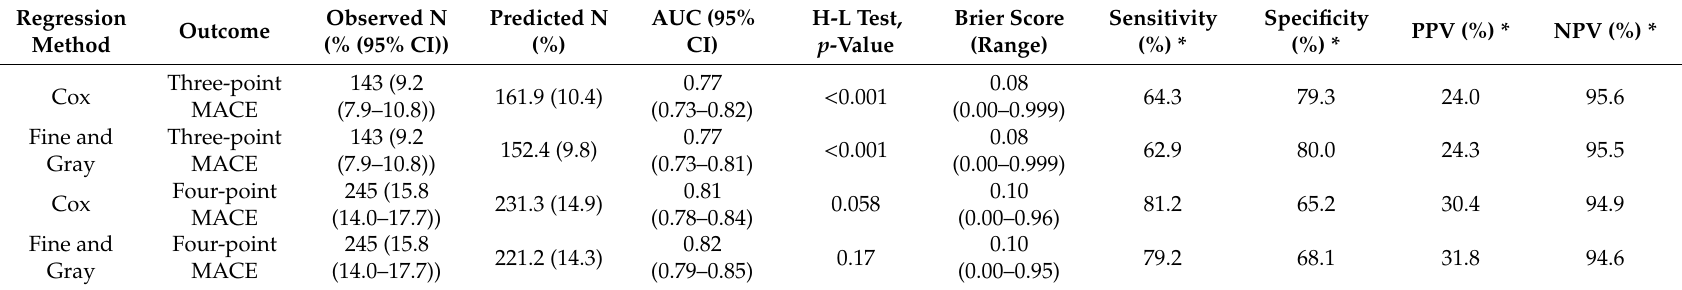
Table 3. Performance of five-year cardiovascular disease risk models for three-point major adverse cardiovascular events (MACE) and four-point MACE derived using a) Cox and b) Fine and Gray competing risk regression